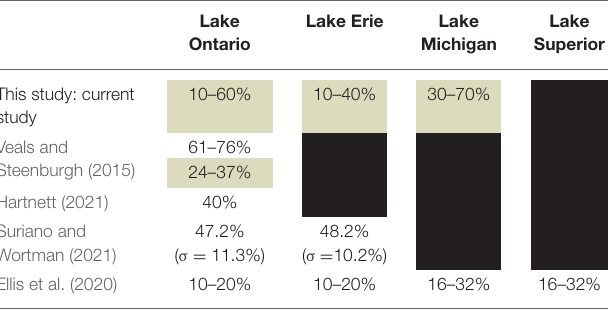
Table cells with gray shading represent contributions reported from LWE and all others represent contributions reported from snowfall